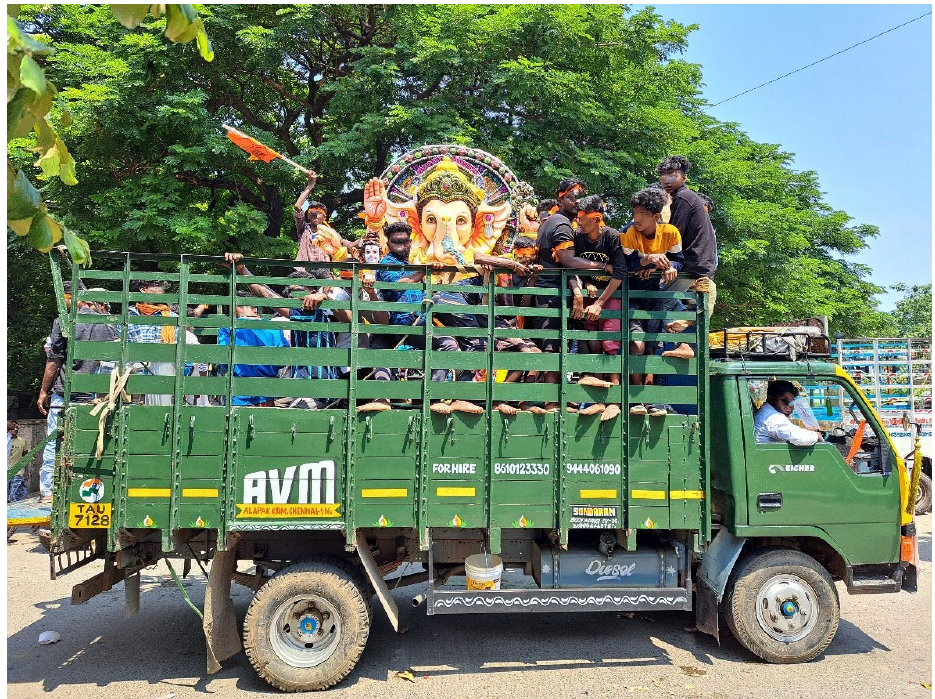
Figure 4. Young men with a Hindu Munnani flag and a Plaster of Paris Ganesha on a cargo truck at Valluvar Kottam on the day of visarjan (immersion) of Ganesha in Chennai. Picture taken by